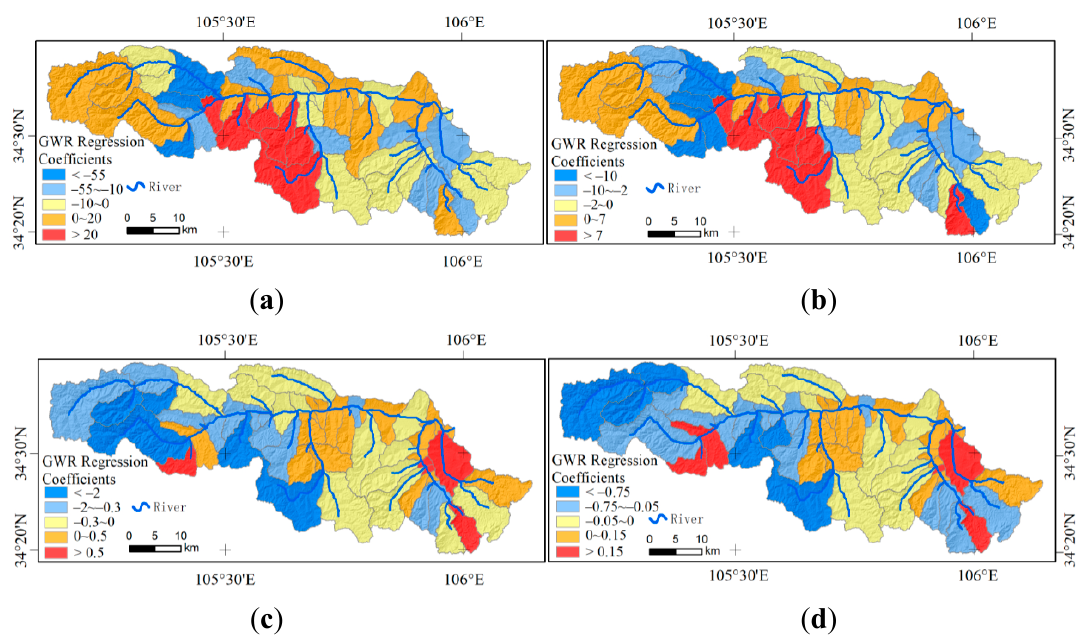
Figure 8. Spatial distribution of GWR regression coefficients from runoff modulus and runoff erosion power in Xihe river basin to multi-year average NDVI and soil steady-state rate. ( a ) Regression coefficients from runoff modulus to multi-year average NDVI. ( b ) Regression coefficients from runoff erosion power to multi-year average NDVI. ( c ) Regression coefficients from runoff modulus to soil steady-state rate. ( d ) Regression coefficients from runoff erosion power to soil steady-state rate.